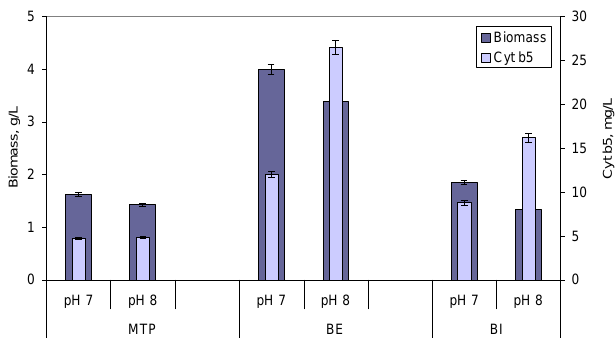
Figure 6. Effect of pH of the growth media on biomass and cyt b5 production by E. coli TB-1 cells.